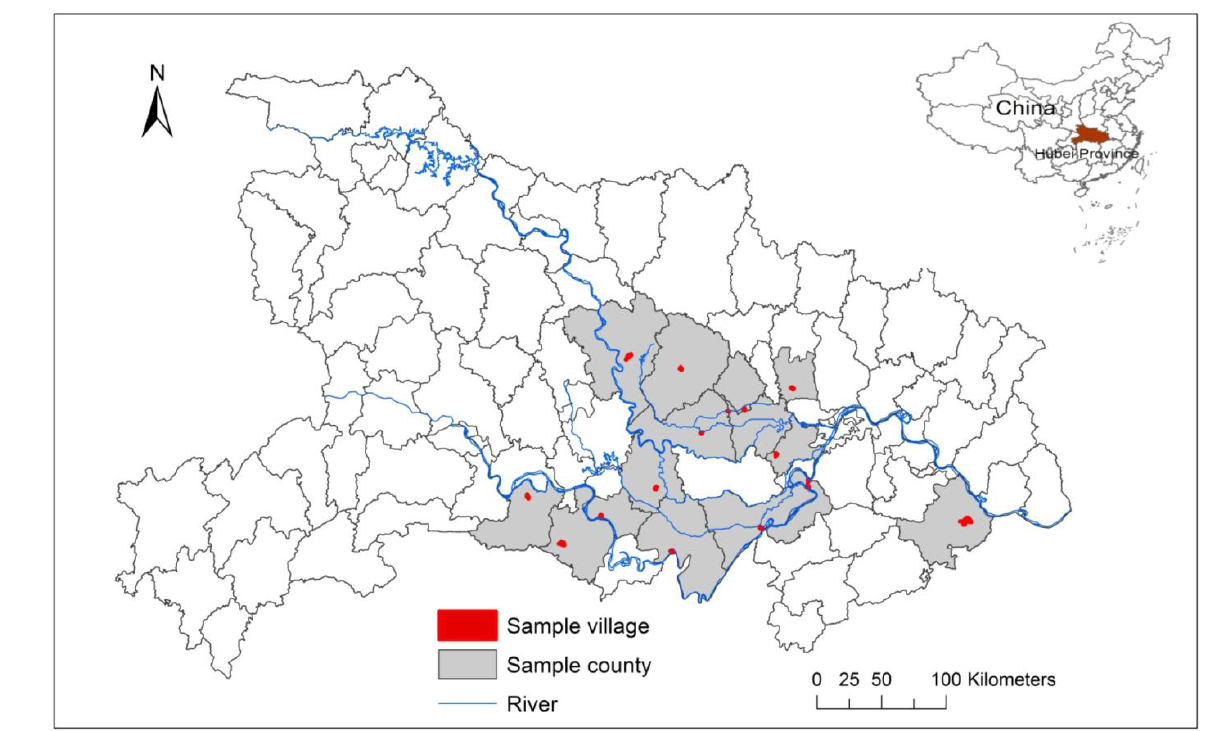
Figure 1. Location of the study counties, Hubei Province,